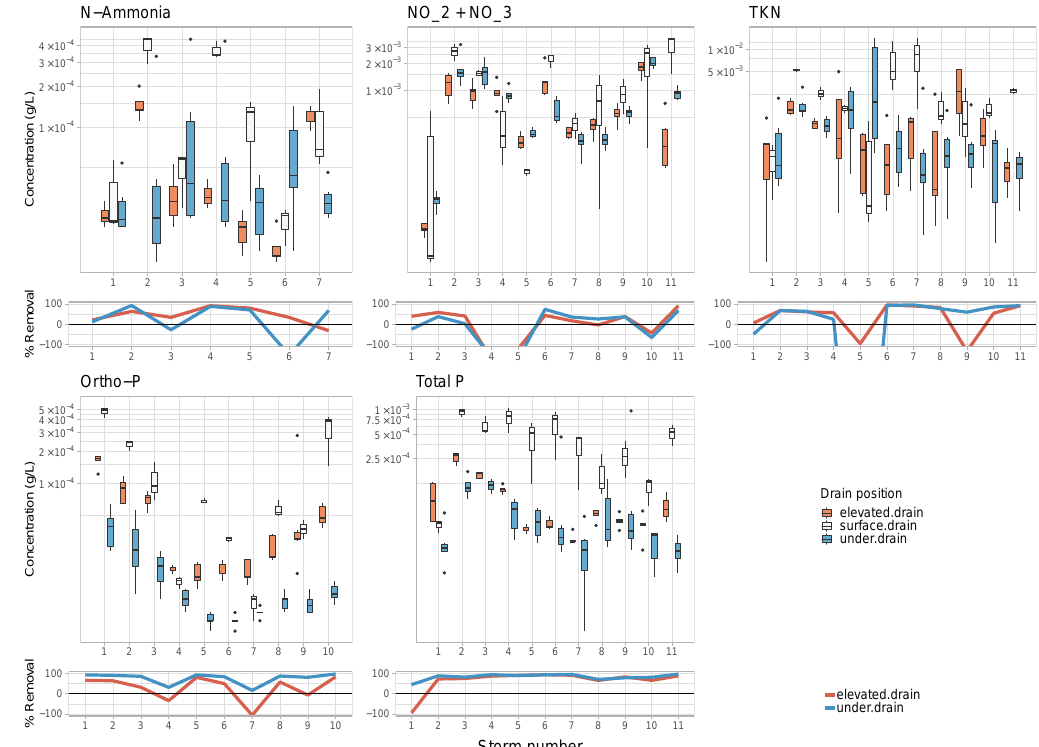
Figure 4. Effluent concentrations for nitrite + nitrate, ammonia, total Kjeldahl N, total P, and ortho-P grouped by storm and drain position [upper row]. The lower panel shows pollutant removal efficiencies across all measured storms. Removal efficiency for TKN-Storm 5 (under drain) was below − 100% (or over 100% export) and is not